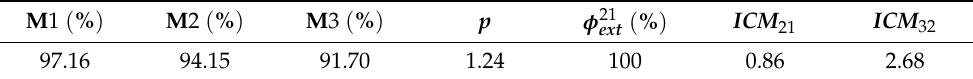
Table 7. Results of the study of mesh convergence for reduced